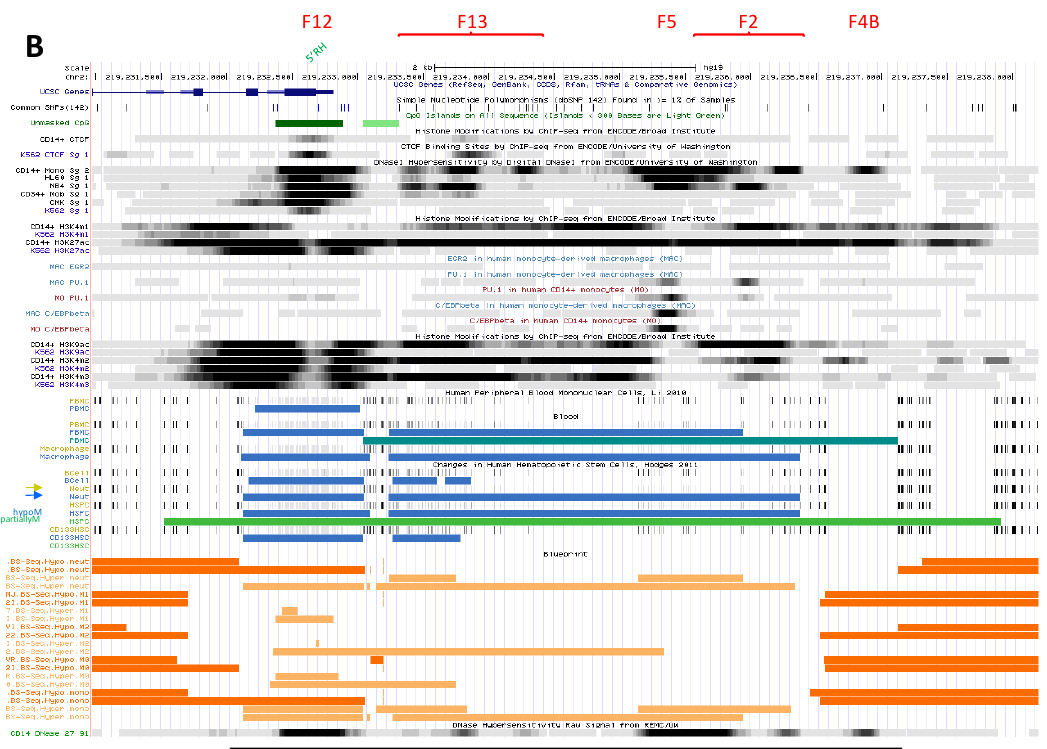
Figure 2. Epigenetic modifications at NRAMP1 locus region ii, encompassing Dnase1 footprints F12/RH, F13, F5 and F2, and F4B (described in text sections: 2.2.3.1, 2.2.3.2, 2.2.3.3 and 2.3.2.4, respectively) part of a candidate super-enhancer domain (data from ENCODE consortium [9,10,78] or stated otherwise). ( A ) From top to bottom : chromosome 2 scale; CpG islands; CTCF sites in CD14 + MNs; UCSC gene descriptions; DNAse1 footprints in CD14 + MNs, HL-60, NB4, mCD34, CMK and K562 cells; EGR2, PU.1 and C/EBPb ChIP-seq data from MNs (MO) and MFs (MAC) [13]; H3K4me1 and H3K27ac ChIP-seq data from CD14 + MNs, K562 cells, HUVEC and ESC; RefSeq genes; H3K9ac, H3K4me2, H3K4me3, H4K20me1, H3K79me2 and H3K36me3 ChIP-seq data from CD14 + MNs, K562 cells, HUVEC and ESC; Black/grey symbols indicate location and intensity of CAGE signals detected in myeloid cells (cf. Figure 1, [68]). ( B ) From top to bottom: chromosome 2 scale; UCSC genes; common SNPs; CpG islands; CTCF ChIP-seq data for CD14 + MNs and K562 cells; DNAse1 footprints in CD14 + MNs, HL-60, NB4, mCD34, CMK and K562 cells; H3K4me1 and H3K27ac ChIP-seq data from CD14 + MNs, K562 cells; EGR2, PU.1 and C/EBPb ChIP-seq data from MO and MAC; H3K9ac, H3K4me2, H3K4me3 ChIP-seq data from CD14 + MNs and K562 cells; CpG hypomethylation data from PBMCs, MFs, B cells, Neutrophils, CD34 + HSPCs and CD133 + HSCs, as well as select Blueprint data (Neutrophils; M1, M2 and M0 MFs; monocytes) [14,15]; DNAse1 footprints in CD14 + MNs; Black/grey symbols indicate location and intensity of CAGE signals (cf. Figure 1); Green symbols highlight hypomethylated areas in MFs, neutrophils and/or CD34 + HSPCs.